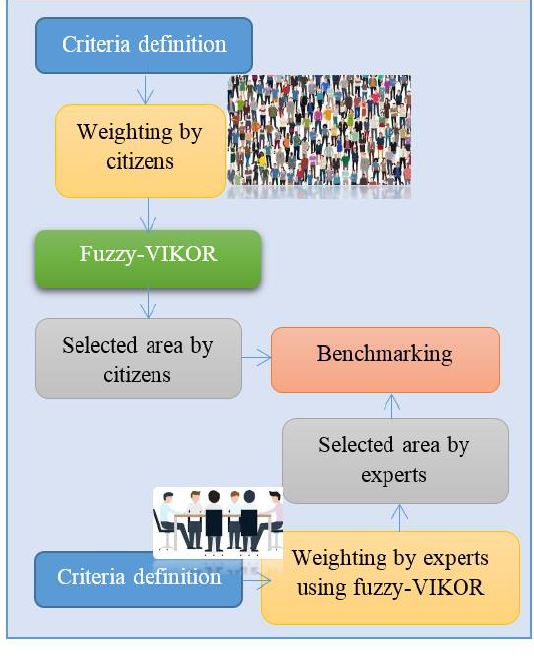
Figure1. Methodology